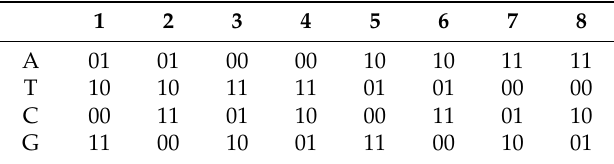
Table 1. DNA coding list [9,24].